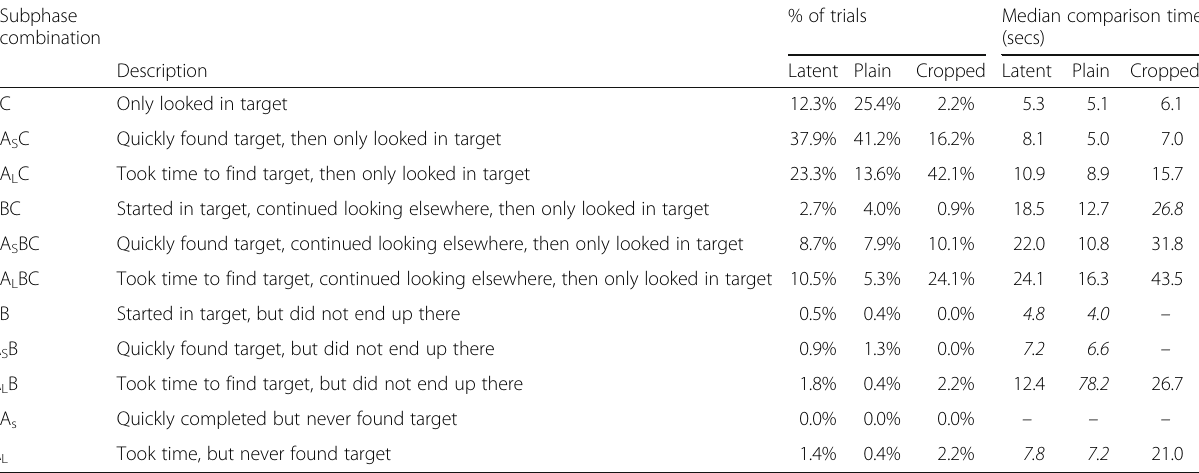
Table 2 Categorization of trials in terms of presence or absence of subphases, with proportions of trials and median comparison times. Rows with similar subphase combinations are grouped. Median times based on three or fewer trials are shown in italics. ( n = 675 trials) Subphase